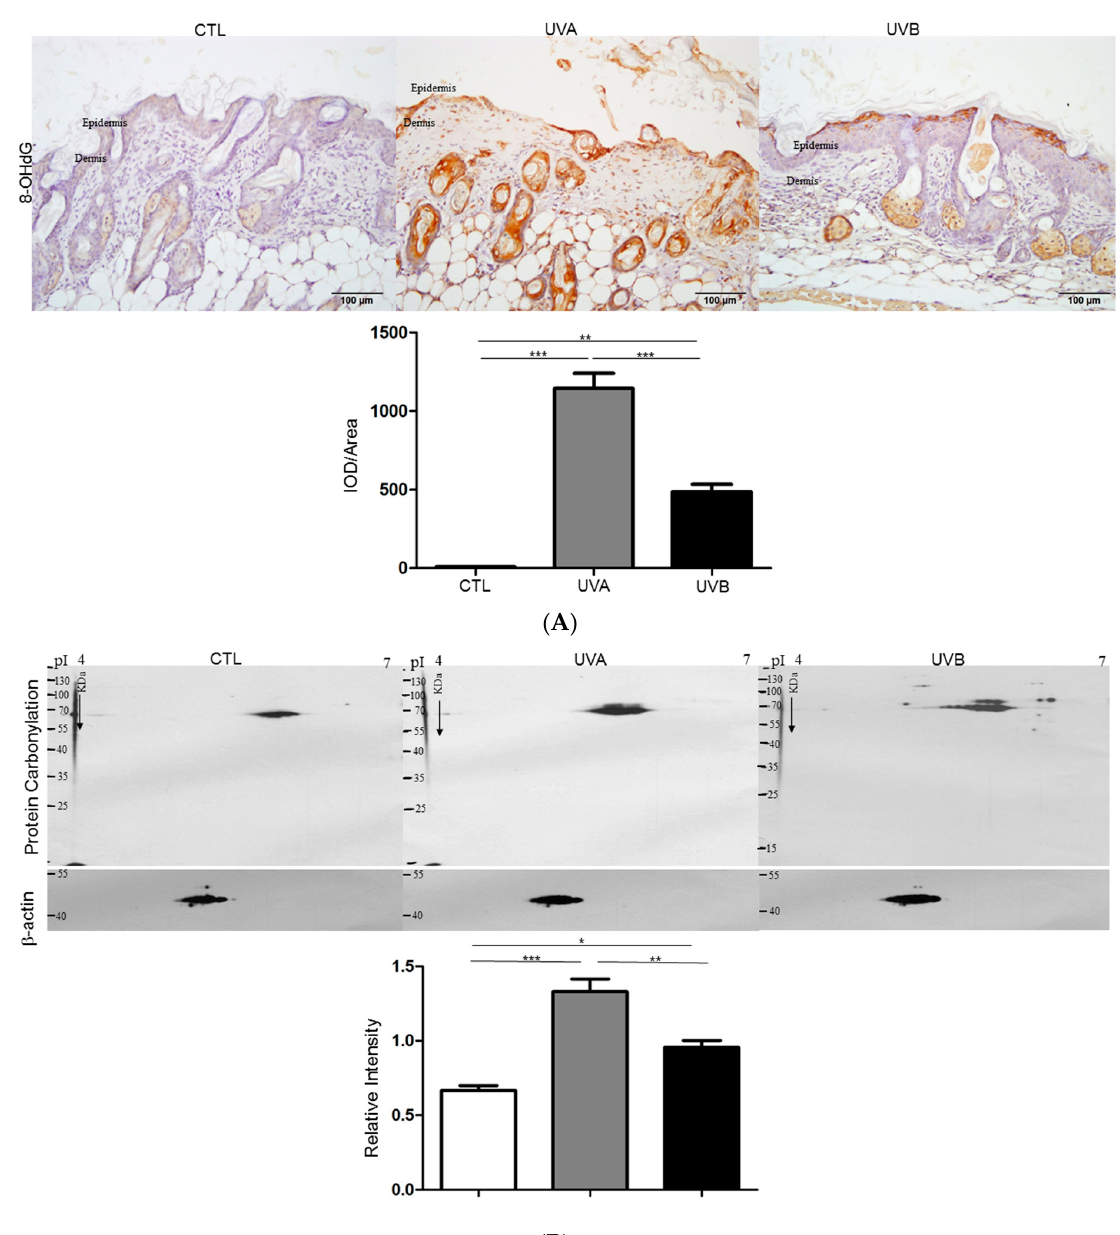
Figure 2. Evaluation of the oxidative stress as well as the antioxidative efficacy of raspberry extract under UVA and UVB exposure. ( A ) 8-Oxo-2’-deoxyguanosine (8-OHdG) levels were determined by immunocytochemistry and 8-OHdG-positive signal was presented as a brown color. The quantified results were indicated with the bar chart. IOD: integrated optical density. ( B ) The levels of carbonylated proteins were indicated and the quantified ratios of protein spots are performed by the bar chart. β -actin was applied as a loading control (* p < 0.05, ** p < 0.01, *** p < 0.001).